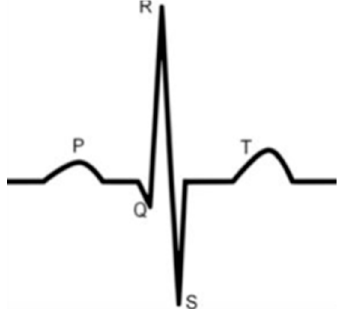
Figure 9. General waveform of an electrocardiogram (ECG).